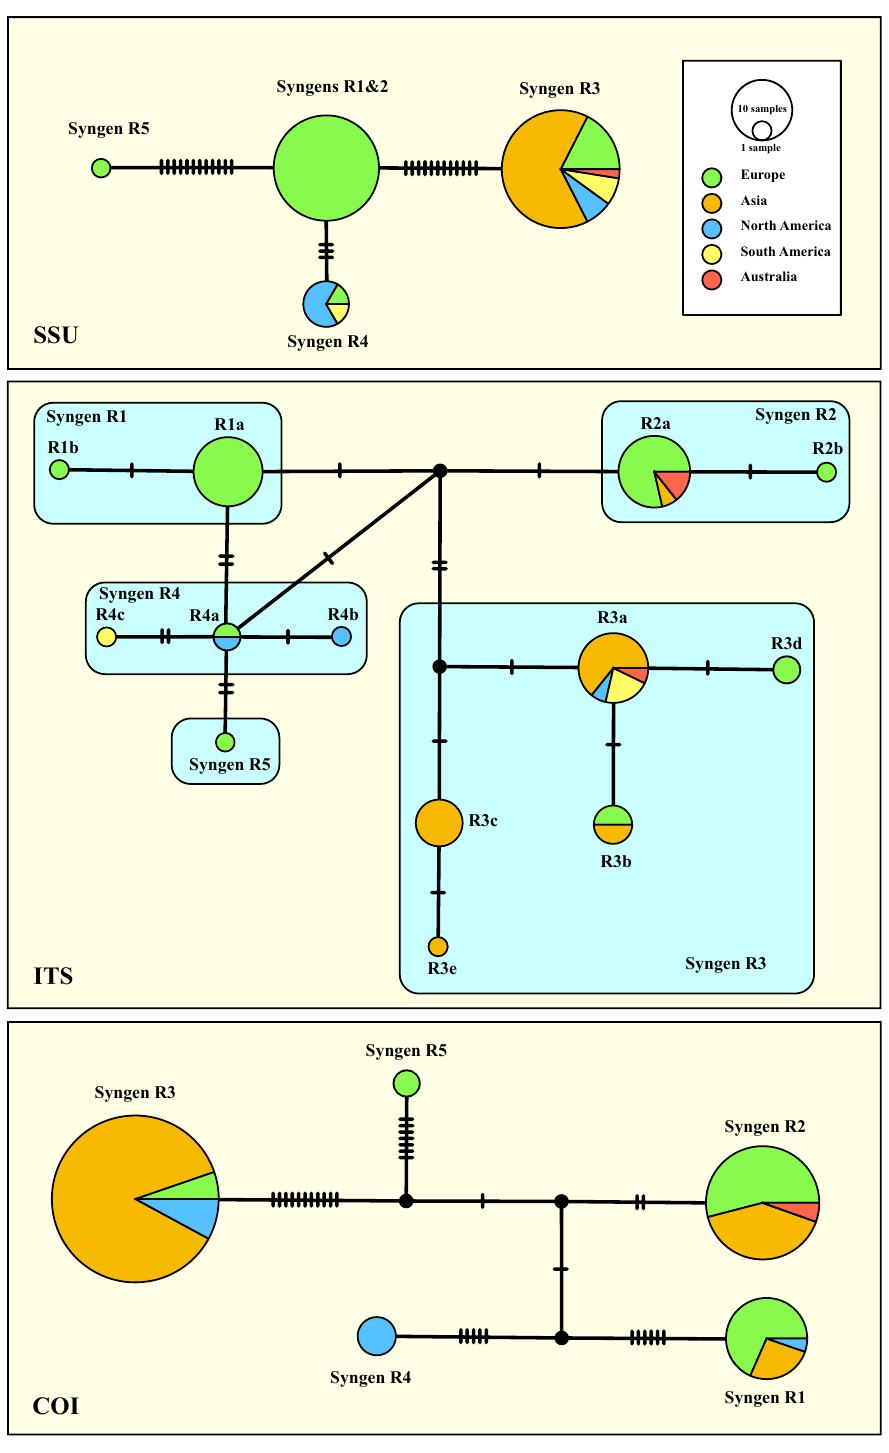
Figure 4. TCS haplotype networks of the five syngens inferred from SSU, ITS rRNA, and COI sequences of the Paramecium bursaria species complex. This network was inferred using the algorithm described by Clement et al. 40,41 . Sequence nodes corresponding to samples collected from different geographical